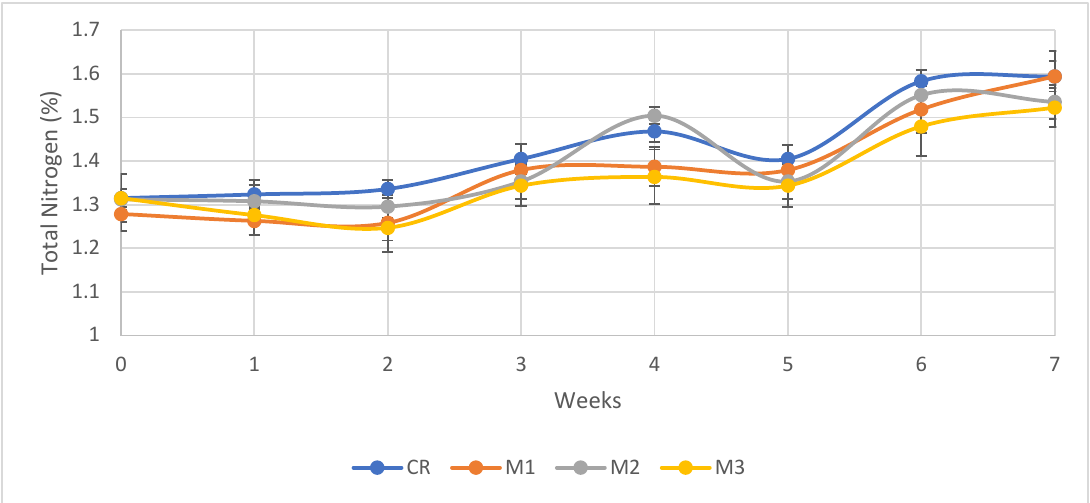
Figure 11. Total nitrogen behavior in mixtures (CR, M1, M2 and M3) during vermicomposting process.